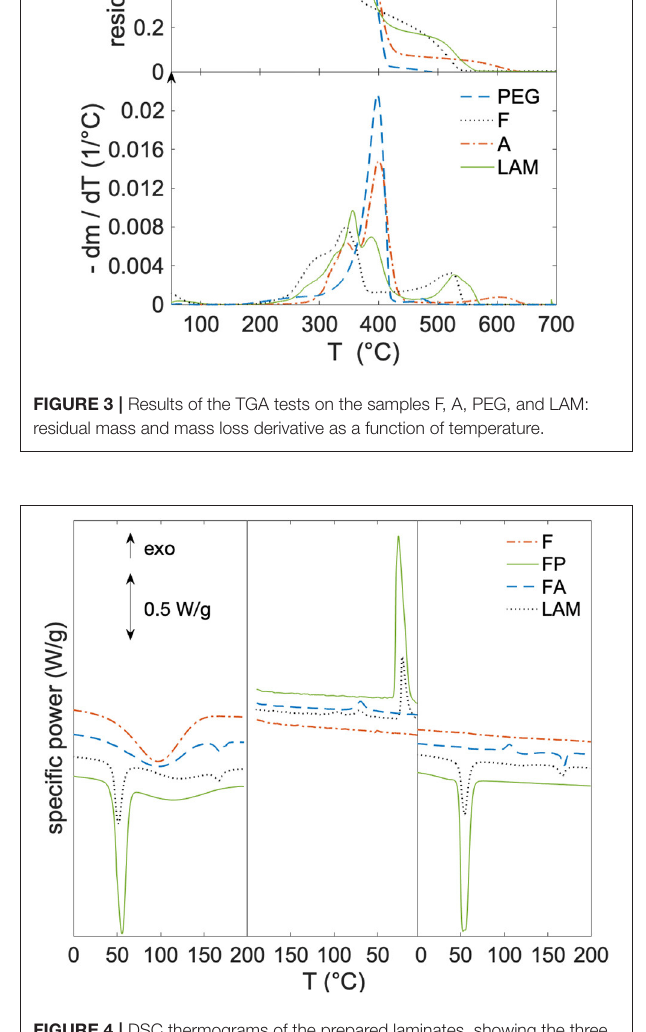
FIGURE 4 | DSC thermograms of the prepared laminates, showing the three scans (first heating, cooling, second heating). Samples F, FP, FA, and